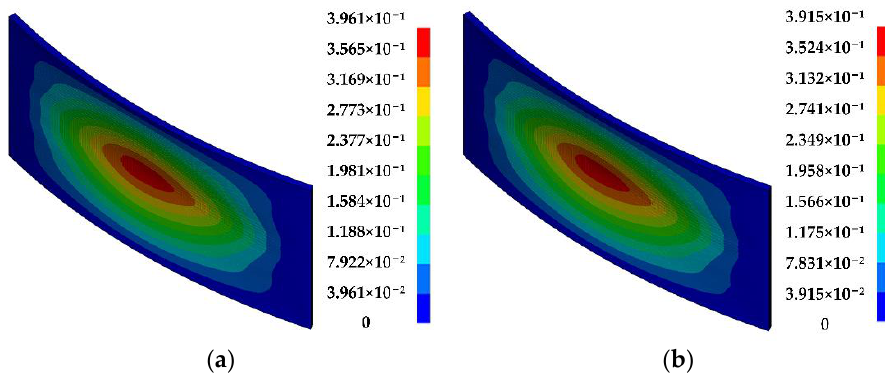
Figure 29. Deformation of blast wall with curvature of 1/20. ( a ) OBW-1; and ( b ) OBW-2.